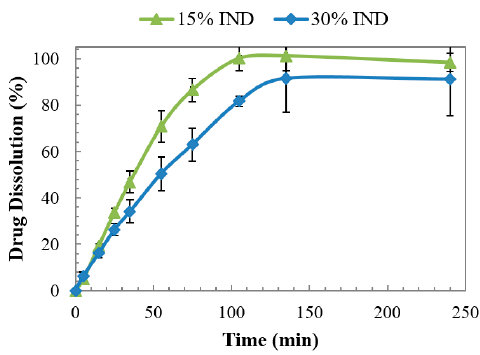
Figure 11. Dissolution of injection moulded tablets of PVPVA-IND solid dispersions in pH 6.8 dissolution medium.